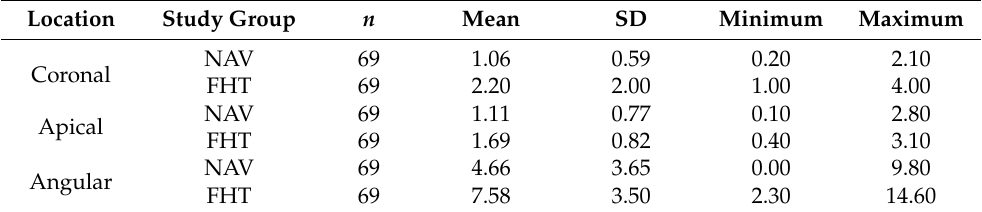
Table 1. Descriptive deviation values at coronal entry-point (mm), apical end-point (mm), and angular (°) levels of the orthodontic micro-screws placed by using conventional freehand technique and computer-aided static navigation tech- nique study groups.